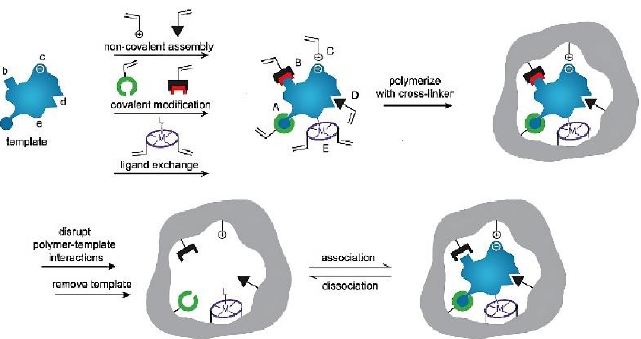
Figure 2. Schematic representation of the molecular imprinting polymerization process. Adapted with permission [26]. Copyright 2006, John Wiley & Sons, Ltd.